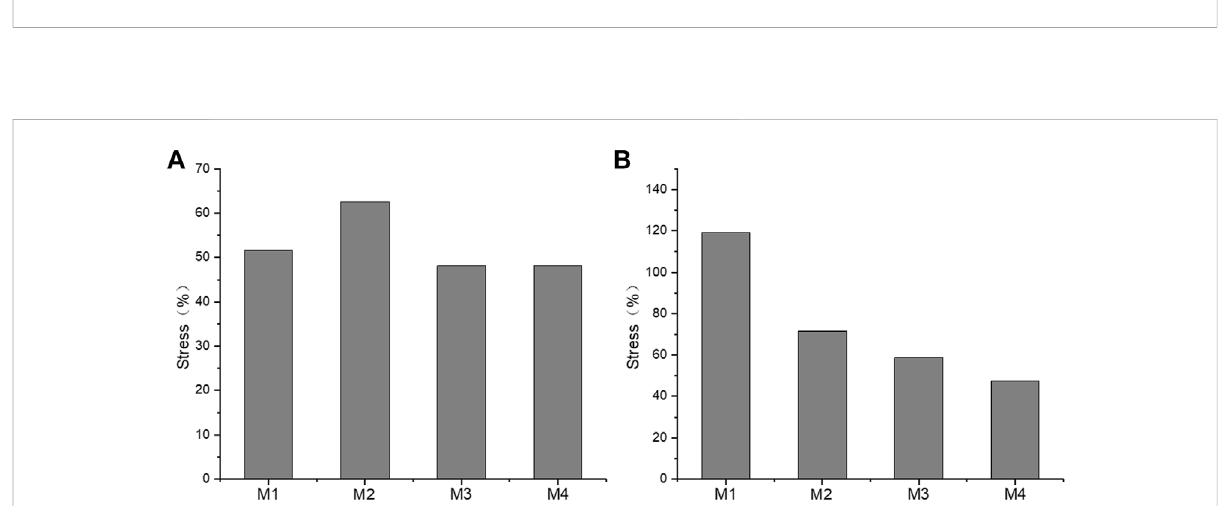
FIGURE 13 The maximum stress of fi ber ring (A) and joint capsule (B) of the M1 – M4